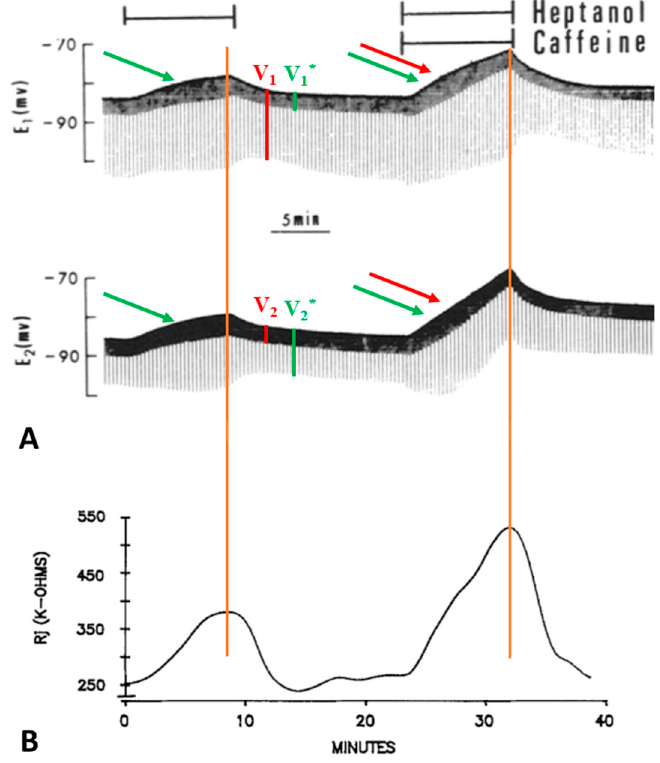
Figure 2. Time course of changes in electrotonic potentials ( A ) and Rj ( B ) in septate axons treated first with heptanol and then with heptanol-caffeine (20 mM caffeine). The Rj recovery rate ( B ) is faster than the onset rate with both heptanol and heptanol-caffeine. Note that the depolarization caused by heptanol (( A ), green arrow) is greater in the presence of caffeine (( A ), green and red arrows). Significantly, the peaks of depolarization correspond to the peaks of Rj (vertical red lines). Adapted from [16].